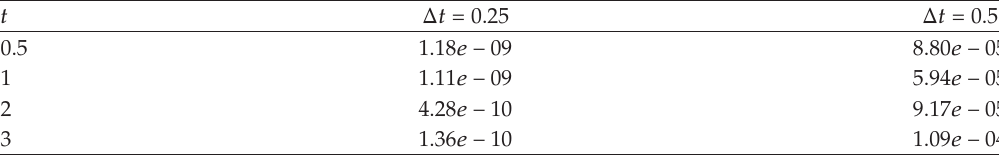
Table 4: Relative errors of Problem 2 with N (cid:6) M (cid:6) 17 using PDQ. t Δ t (cid:6) 0 . 25 Δ t (cid:6) 0 . 5